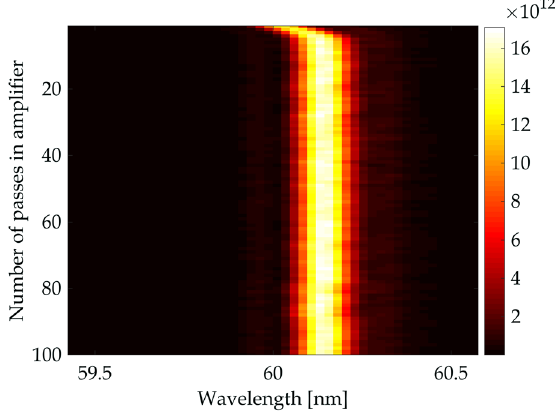
FIG. 14. Output 4.17 nm spectra for the three cases with the same lattice and input electron beam parameters. For the HGHG simulations, this is the 12th harmonic of 100 nm seed laser. For the multipass HGHG, we show the results for the 65th pass. The domain shows a wavelength range of (cid:2) 3 ρ around the central wavelength of the single-pass HGHG. For the SASE simulation, the amplifier is extended to reach saturation.